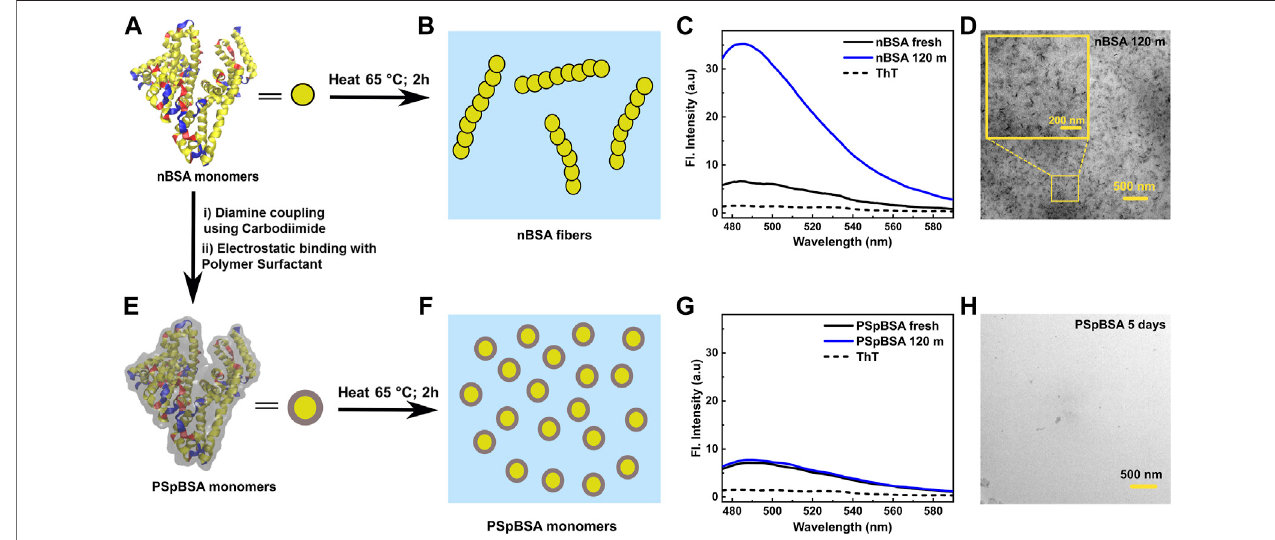
FIGURE 1 | (A) Graphical representation of a nBSA monomer (PDB 3V03) using VMD software: α -helixes are yellow, β -sheets are blue and the red stands for random coil; for simplicity the protein is also sketched as yellow disk. (B) Schematic illustration of how nBSA monomers aggregate to form fi laments. (C) ThT-emission spectra taken from a fresh 100 μ M nBSA solution (pH 7.0, 50 mM NaCl, 25 ° C) and the same solution heated for 2 h at 65 ° C. For reference, the dashed line was measuredforpurePBcontainingthesame fi nalThTconcentrationastheproteinsamples. (D) TEMimageofnBSA fi brilsformedafterheatingat65 ° Cfor2 h.Inset shows amagni fi edversion oftheimage. (E) Graphical representation ofpolymer-surfactant conjugatedPSpBSA (moredetailsaregivenin SupplementaryFigure S19 [41]. The grey layer enveloping the protein represents the polymer-surfactant (PS) layer, coating each monomer. (F) Schematic representation of PSpBSA monomers after subjecting them to aggregation conditions. (G) ThT- fl uorescence spectra of the fresh and heat-set PSpBSA solutions. As in (C) , the dashed line represents the fl uorescence activity of ThT in pure PBS. Again, the same protein and ThT concentrations were used (see Experimental Section). (H) TEM images of PSpBSA solution showing aggregate free sample after heating at 65 ° C for 5